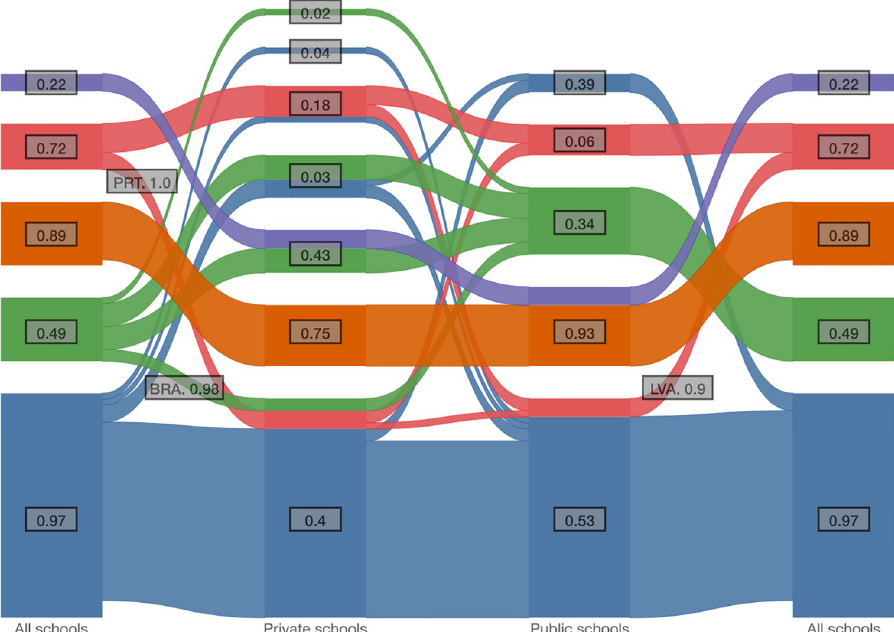
Fig 5. An alluvial diagram showing how the clustering of countries changes when considering all schools, private schools or public schools, and the bootstrap support of the clusters. The clustering of countries using data only from private schools is fragmented and some of the clusters have low bootstrap support. We can however see, for example, that Portugal and Brazil both change cluster to the blue cluster, which is characterized by privileged students over the whole scale of performance, when considering private schools